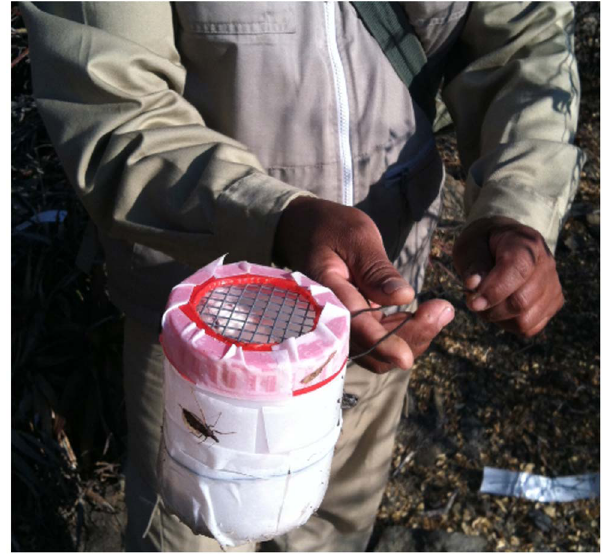
Figure 2. Noireau sylvatic insect vector trap. Traps consisted of plastic containers with a live mouse and wire mesh tops. Double sided sticky tape was placed on the outside of the traps.